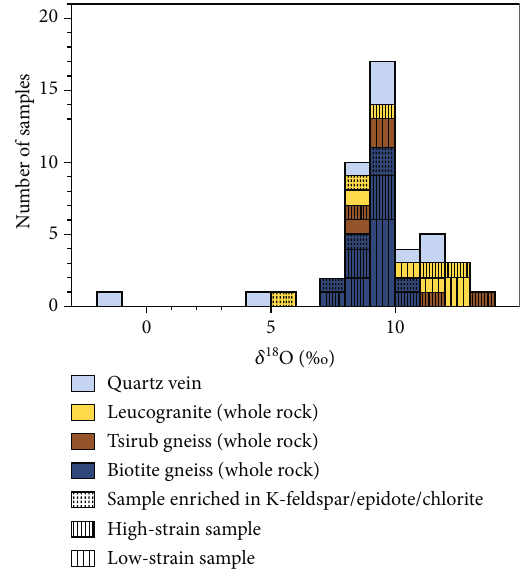
Figure 12: Oxygen δ 18 O spread for the 9 : 5 ± 1 : 5 ‰ ( n = 35 ; Figure 12; Table S1). The two gneisses have mean δ 18 O values below and above this average, with the biotite gneiss predominantly hosting lower values ( mean = 9 : 1 ± 0 : 6 ‰ ) and Tsirub Gneiss conversely the higher ( mean = 10 : 6 ± 1 : 5 ‰ ). Whole rock δ 18 O values obtained from the leucogranite are spread over the whole range ( mean = 10 : 6 ± 1 : 6 ‰ ). The lowest whole rock δ 18 O value of 5.4 ‰ is from a granitic sample adjacent to the quartz vein in area A with the low quartz δ 18 O value of -1.2 ‰ (Figure 2). Samples with increased abundance of chlorite and/or epidote or K-feldspar also have lower whole rock δ 18 O values, in general, than both high- and low-strain